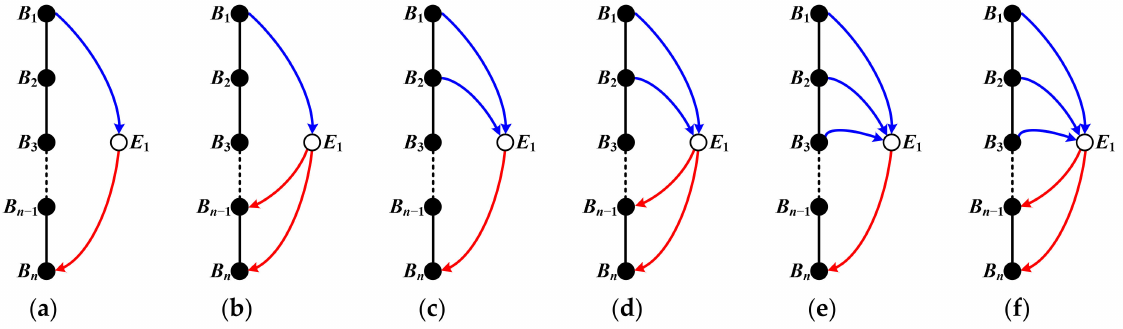
Figure 2. Possible operation modes of a MC2MC equalizer. ( a ) 1–1 mode. ( b ) 1–2 mode. ( c ) 2–1 mode. ( d ) 2–2 mode. ( e ) 3–1 mode. ( f ) 3–2